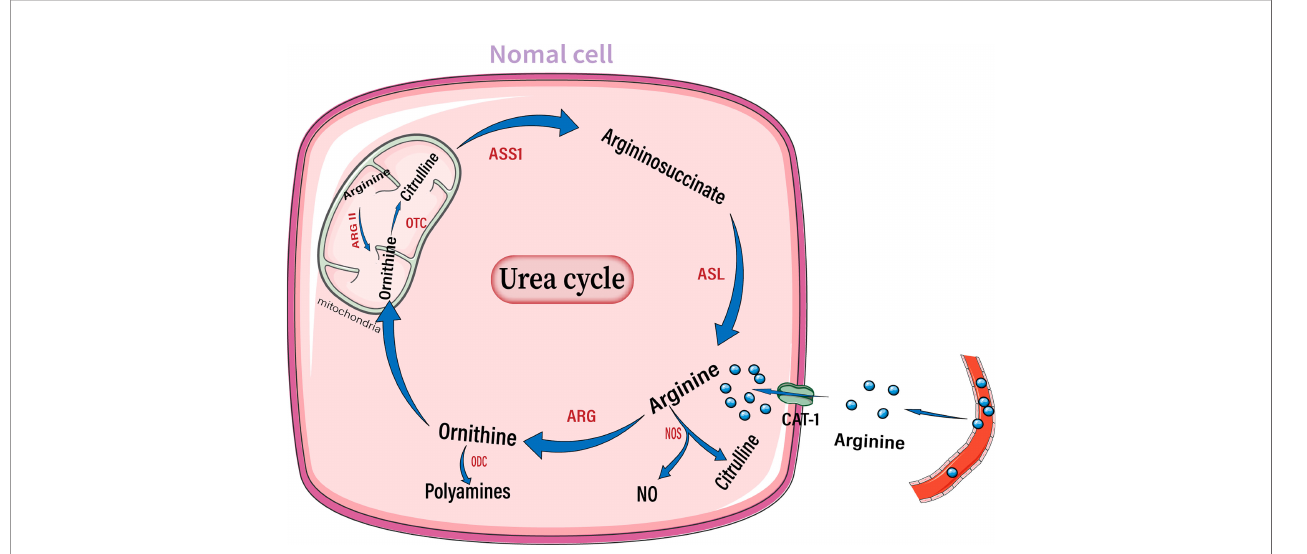
FIGURE 1 | Diagram of the arginine metabolism pattern in normal cells. After entering the extracellular matrix from the circulation, arginine enters the cell through the CAT-1 transporter on the cell membrane. Arginine can be broken down by NOS into NO and citrulline, or be broken down by arginase into ornithine, thus entering the urea cycle. Ornithine can also generate polyamines through ODC. Arginase II in mitochondria is also involved in the degradation of arginine. NO, Nitric oxide; NOS, nitric oxide synthase; ARG, arginase; ODC, ornithine decarboxylase; OTC, ornithine transcarbamylase; ASS1, argininosuccinate synthase; ASL, argininosuccinate